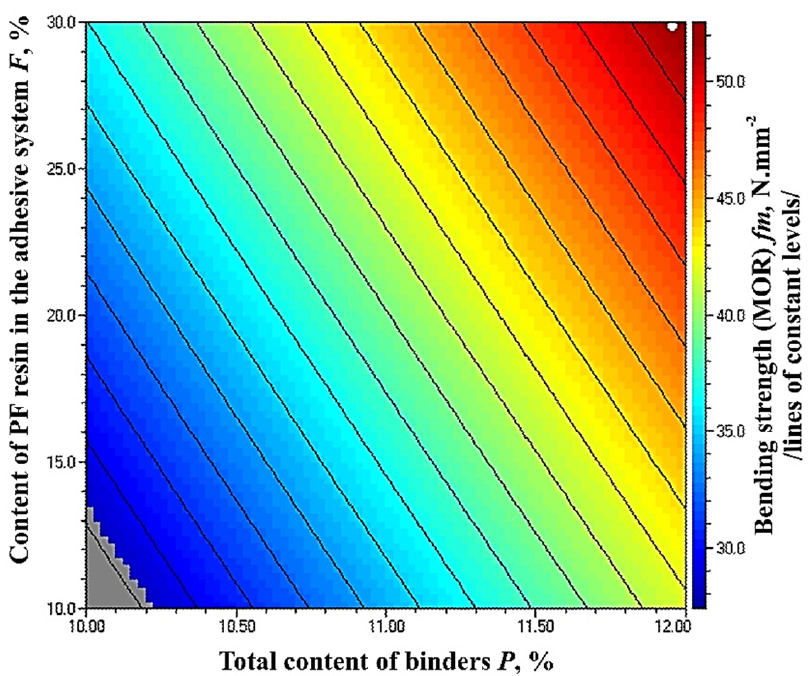
Figure 6. Effect of binder content and PF resin content in the adhesive system on the MOR values of fiberboard panels.